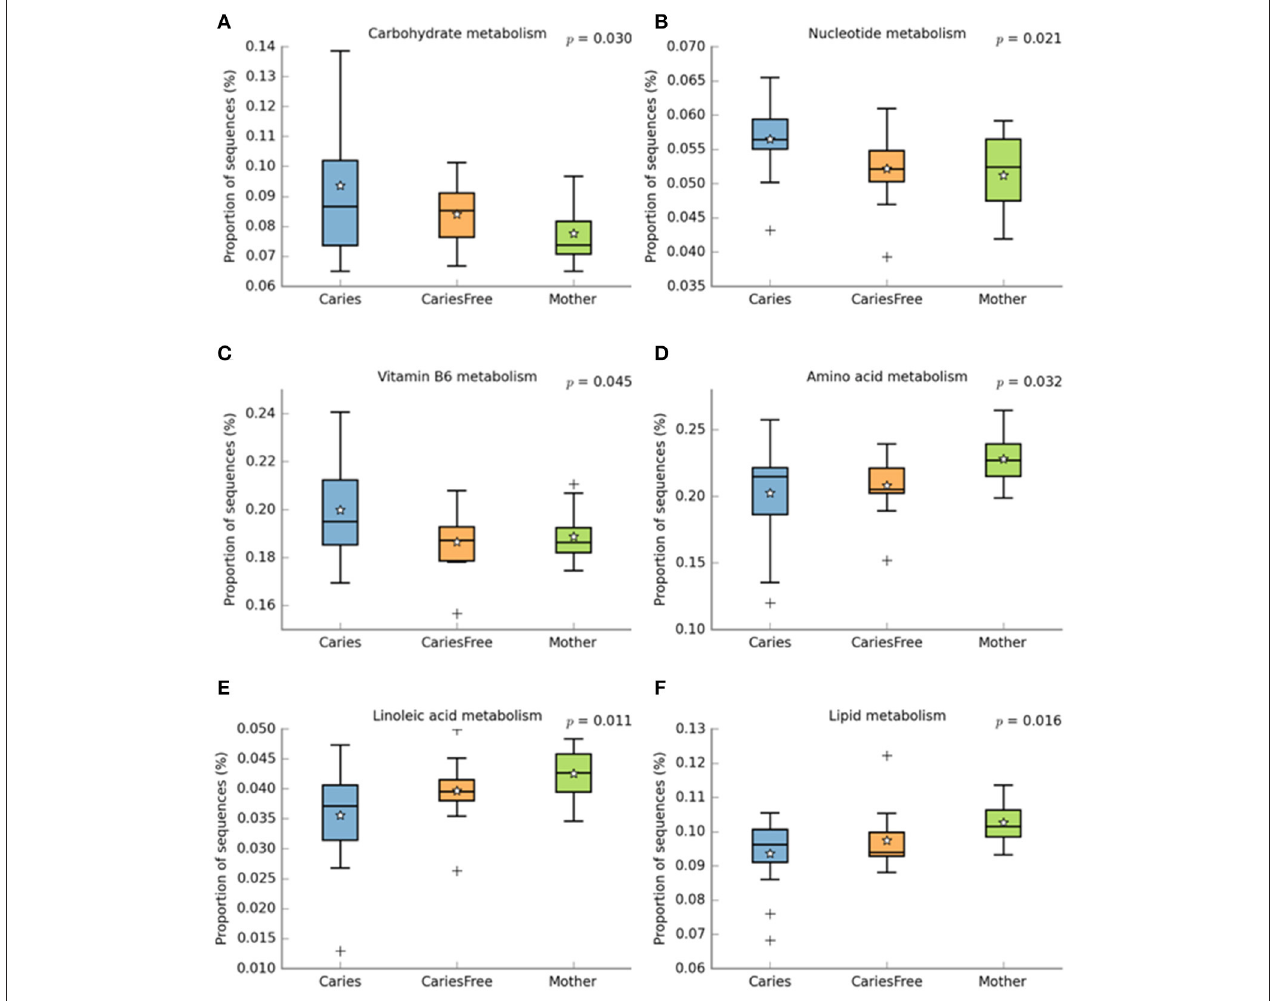
FIGURE 7 | PICRUST analysis to predict metagenome functional content from 16S rRNA surveys, then use STAMP software package for analyzing metabolic profiles that promote “best practices.” Using STAMP to identify metabolic activities which are differentially abundant between different groups. (A–C) shows metabolic activities which are abundant in caries children; (D–F) represent metabolic activities which are abundant in mother group. + shows the presence of outliers.